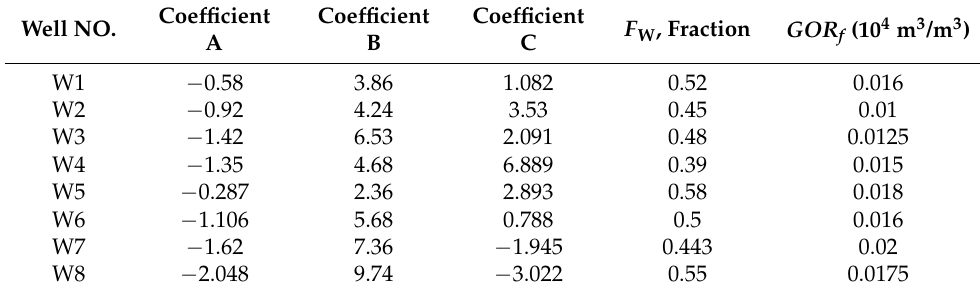
Table 1. Coefficients of GLPCs, water cut and formation gas–oil ratio of various wells. Well NO.